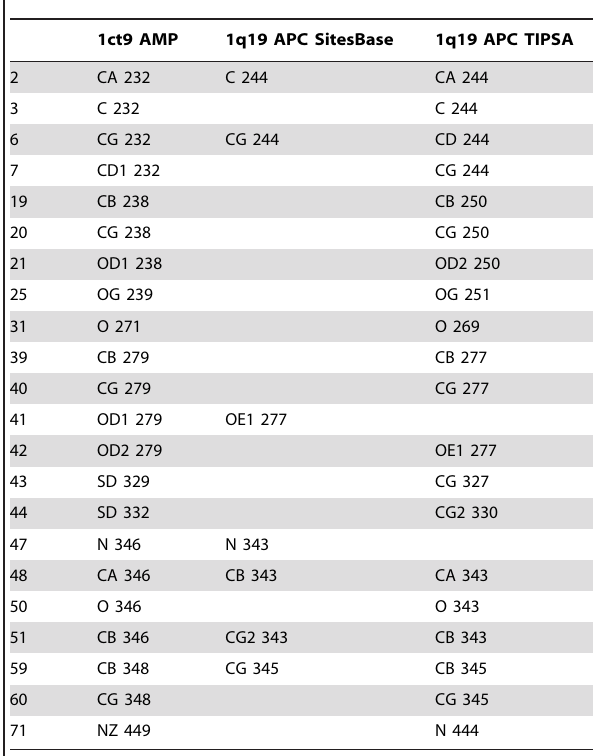
Table 10. Matched atoms from the AMP binding site of 1ct9 and APC binding site of 1q19 found only by either SitesBase or